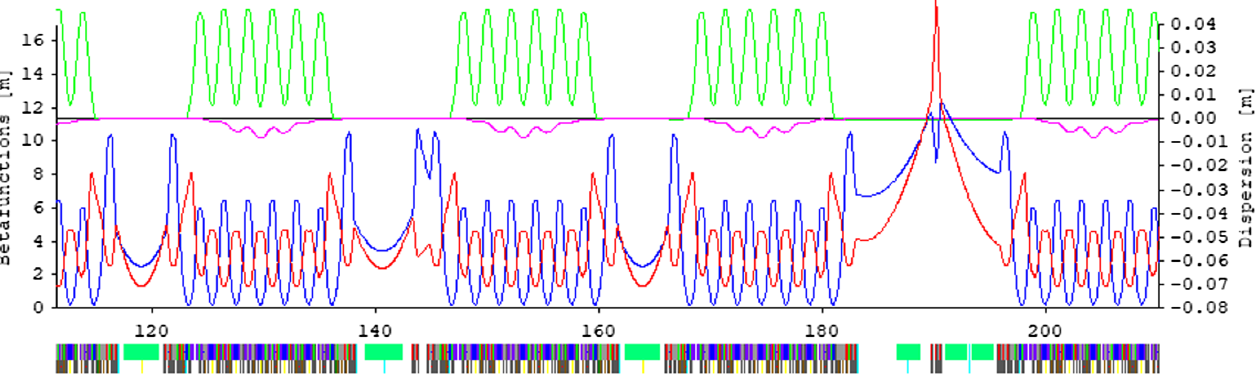
4. Normal normal mode beta functions (blue a -mode, red b -mode) and dispersions (green horizontal, magenta vertical) for sectors 6 to 9 of the SLS 2.0 lattice loaded with insertion